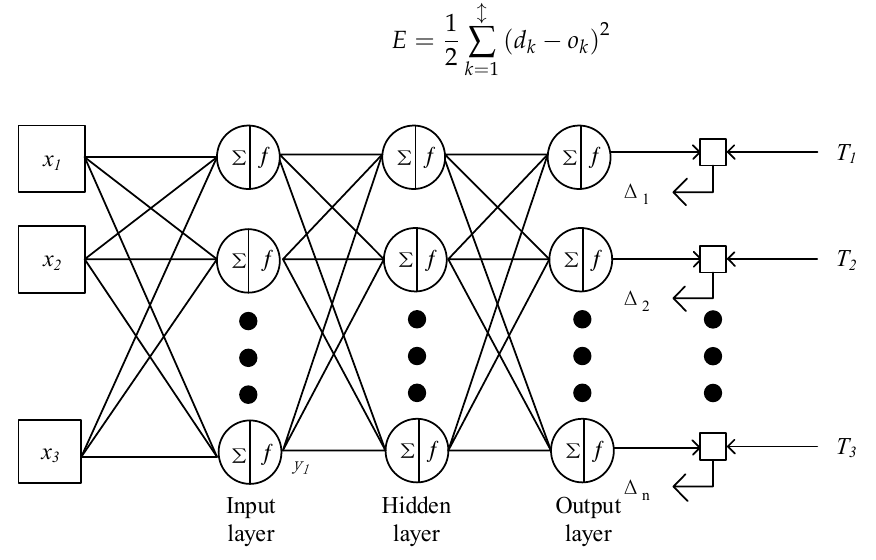
Figure 2. Three ‐ layer BP neural network. Figure 2. Three-layer BP neural